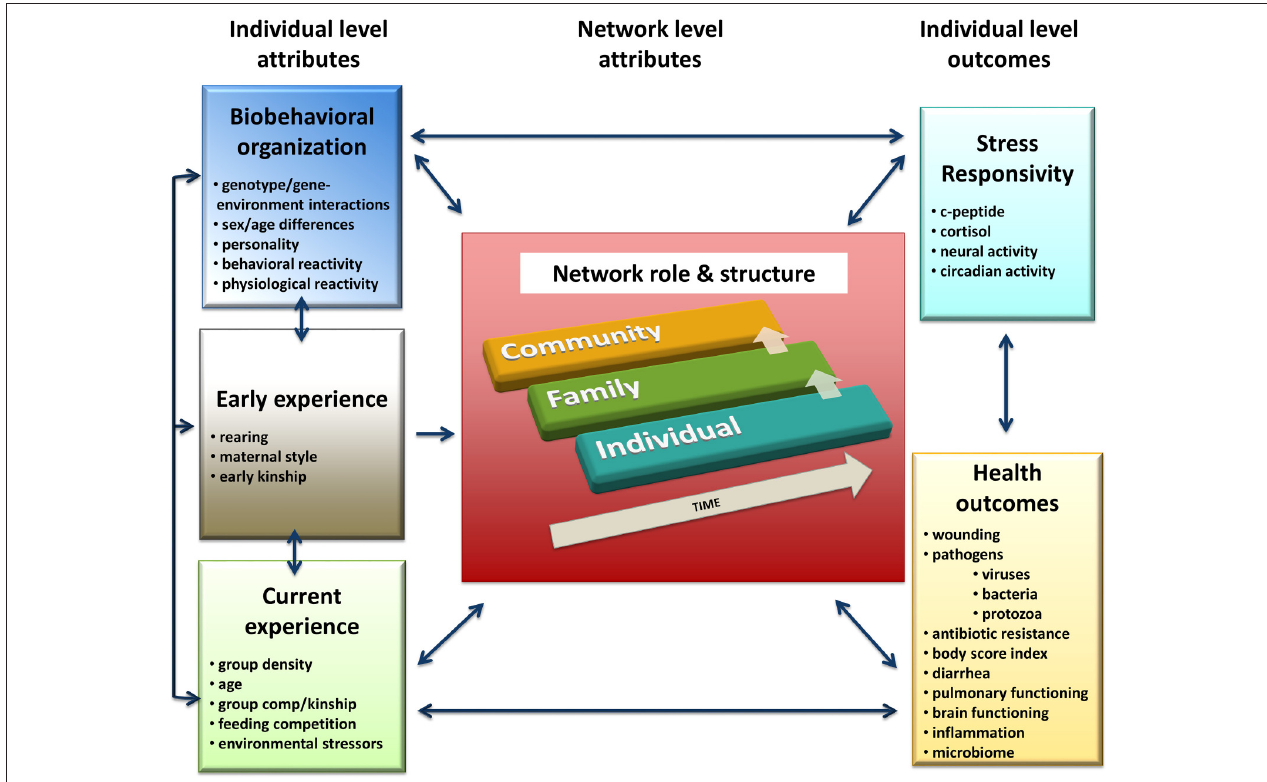
FIGURE 1 | Unifying conceptual framework for effects of individual characteristics and environmental/social stressors on network structure and dynamics leading to positive or negative health outcomes at each life stage and across the lifespan. Arrows indicate possible direction(s) of effects including reciprocal